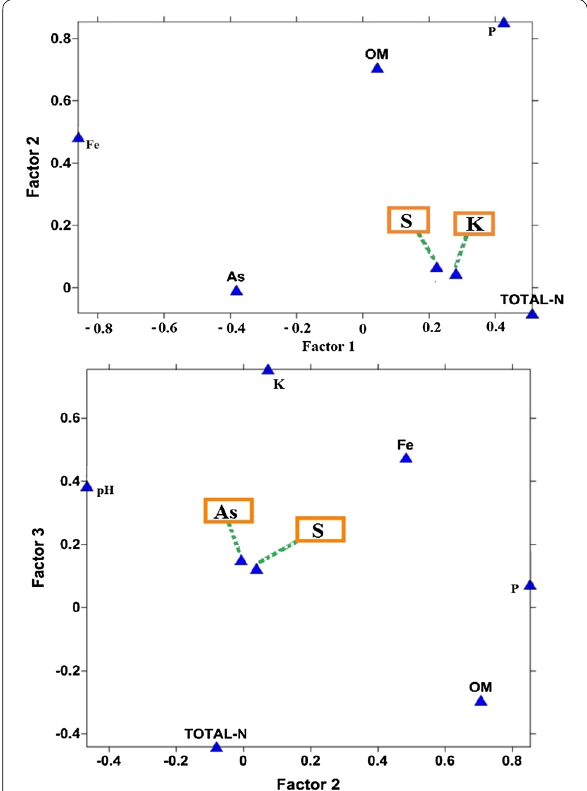
Fig. 2 The relationship between different factors for surface soil